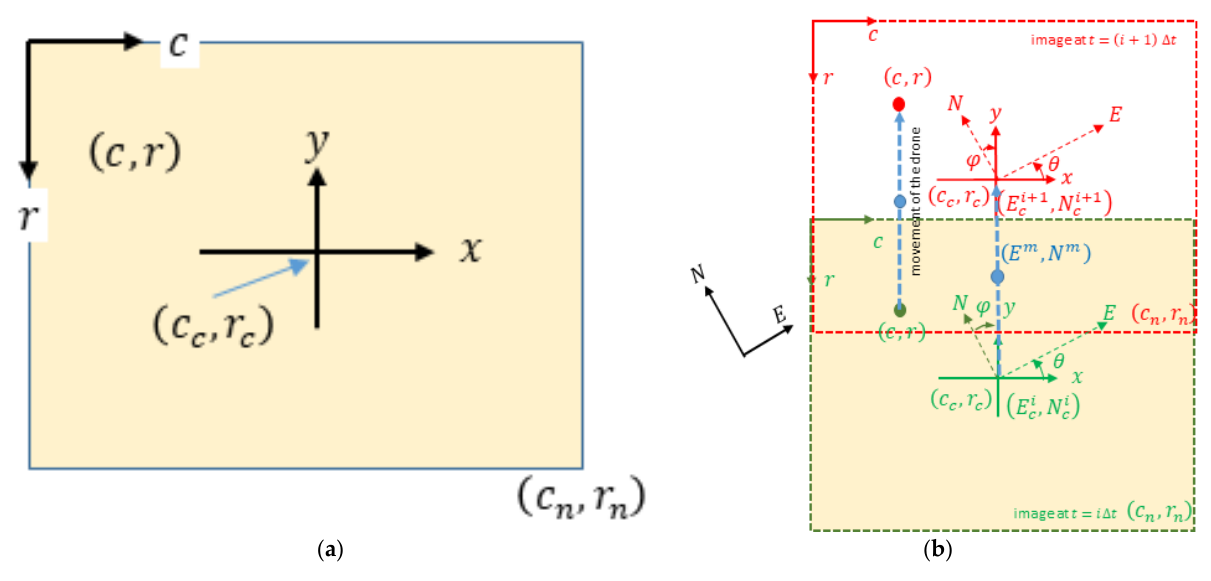
Figure 1. Coordinates systems used: ( a ) image coordinates and local physical coordinates; ( b ) local physical coordinates and global coordinates.